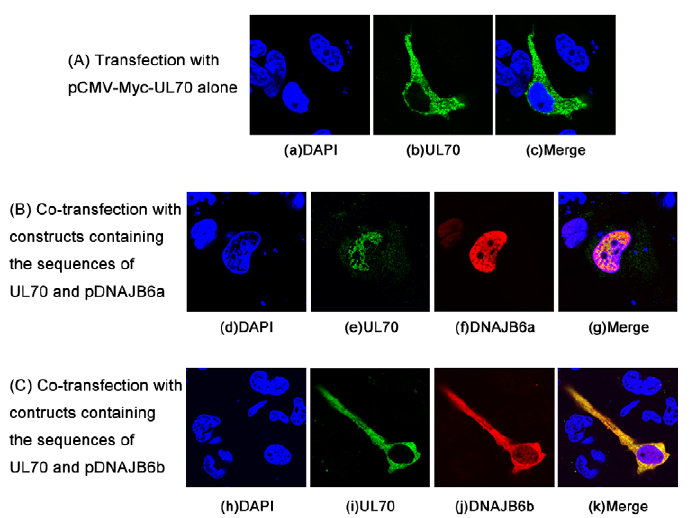
Figure 3. Co-localization of UL70 and DNAJB6a and DNAJB6b expressed in human cells. Cells were transfected with the construct containing the sequence of Myc-tagged UL70 alone (A) and in the presence of the constructs containing the sequences of FLAG-tagged DNAJB6 (a and b) (B and C), fixed at 48 hours posttransfection, stained with antibodies, and visualized using a microscope. The images of Myc-tagged UL70 (b, e, i), FLAG-tagged DNAJB6a (f) and DNAJB6b (j), and the nuclei stained with DAPI (a, d, h) were used to generate the composite images (c, g, k). The images show different levels of magnification.